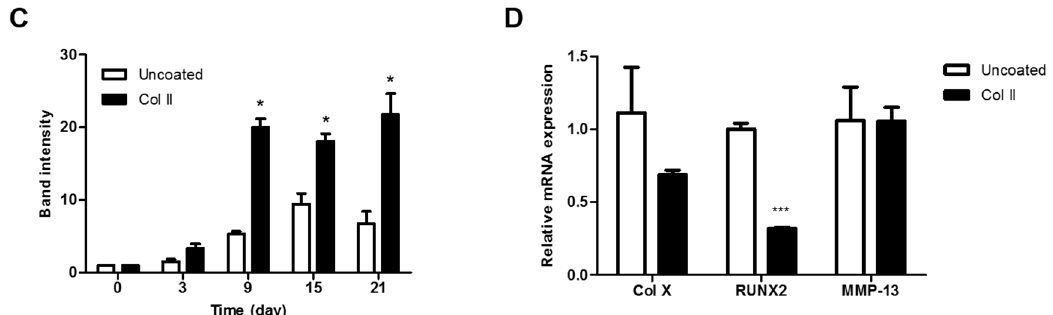
Figure 4. MMP-2 activity in hASCs during chondrogenic differentiation on Col II-coated plates. ( A ) The mRNA level of MMP-2 of Cd-ASC was determined on normal and Col II-coated plates by qPCR; ( B ) the MMP-2 activities of Cd-ASC were measured on normal plates and Col II-coated plates by zymography; ( C ) the quantitative data of MMP-2 band intensity (in panel B) was measured using ImageJ software; and ( D ) the expression of hypertrophic marker genes, COL X , RUNX2 , and MMP-13 , was investigated by qPCR. The data are shown as the mean ± SEM ( n = 3, *: p < 0.05, ***: p < 0.0005).